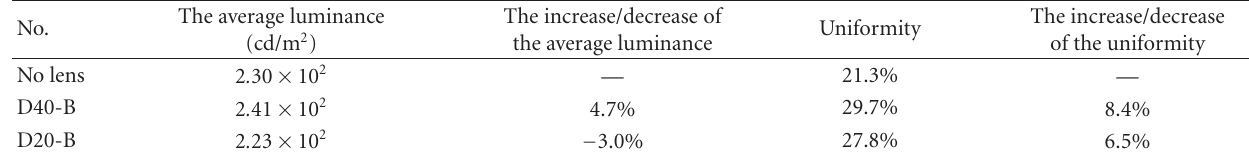
Table 8: The optical measurement of the average luminance and the average uniformity.